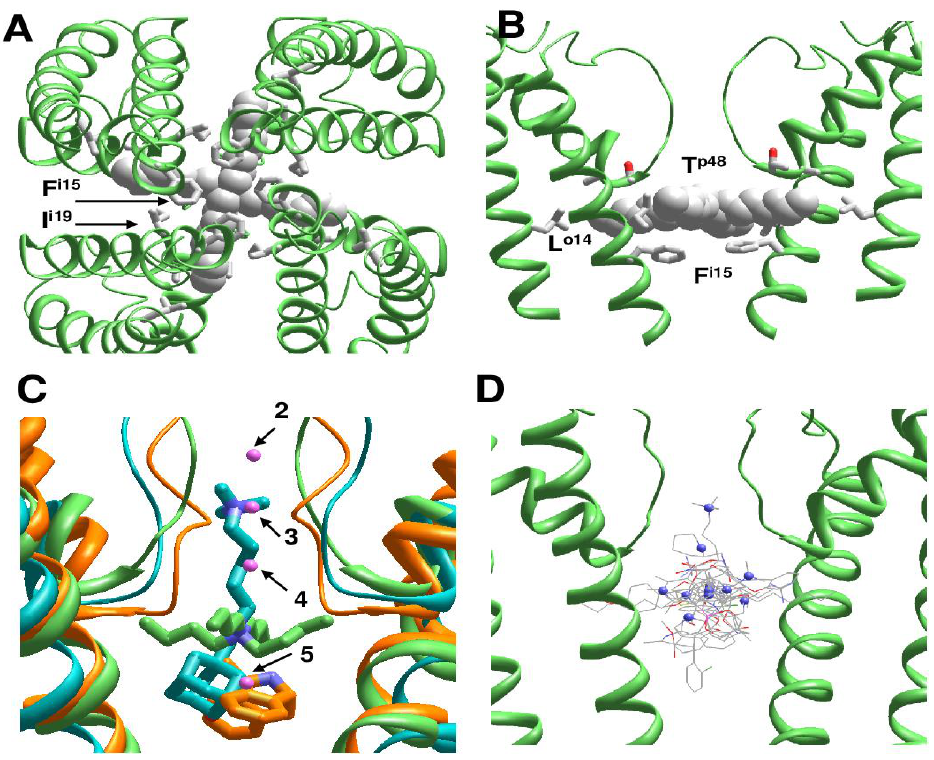
Figure 3. KcsA pore domain (green helices) with superimposed ligands from KcsA, GluR, NavAb, and CavAb channels. A and B, Intracellular and intra-membrane views of the KcsA complex with tetradecylammonium (PDB ID: 2w0f). The ammonium nitrogen is at the focus of P-helices. Long decyl chains penetrate into subunit interfaces and reach the outer helices. Main channel contributors to the ligand-binding energy are shown by sticks. C , 3D-aligned structures of TBA-bound KcsA (PDB ID: 2hvj) (green backbone and ligand carbons), MK801-bound NMDAR channel (PDB ID: 5un1) (orange backbone and ligand carbons), and IEM-1460 bound AMPAR channel (PDB ID: 6dm0) (cyan backbone and ligand carbons). The central cavity of the channels accommodates bulky moieties of TBA, MK801, and IEM-1460. Magenta spheres show potassium ions in Cd 2+ -bound KcsA (PDB ID: 3stl). The terminal ammonium group of IEM-1460 penetrates into the selectivity filter and binds near Site 3 of potassium ion; the second ammonium nitrogen binds close to the position of TBA ammonium nitrogen in KcsA. The ammonium group of MK801 binds in the central cavity, close to Site 5 of potassium ion KcsA. D , Ammonium nitrogen atoms of cationic drugs (blue spheres) scatter over the central cavity.